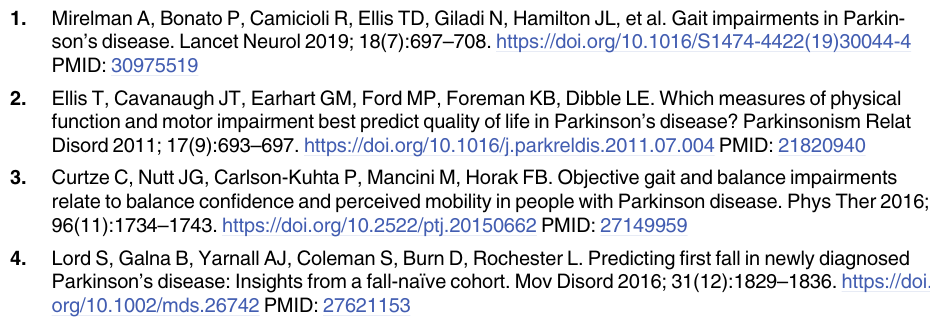
S1 Table. Gait parameters at baseline of symptomatic leg vs. asymptomatic leg at